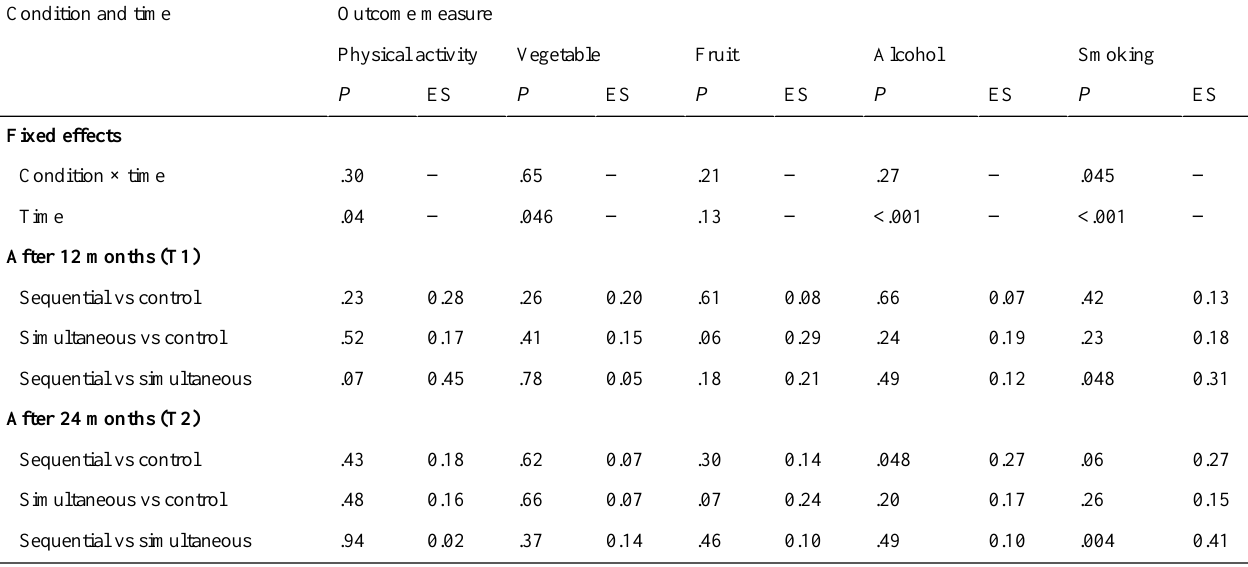
Table 3. Results of the logistic mixed model analyses (top-down procedure) a with the specific lifestyle behavior (guideline status) after 12 and 24 months as outcome